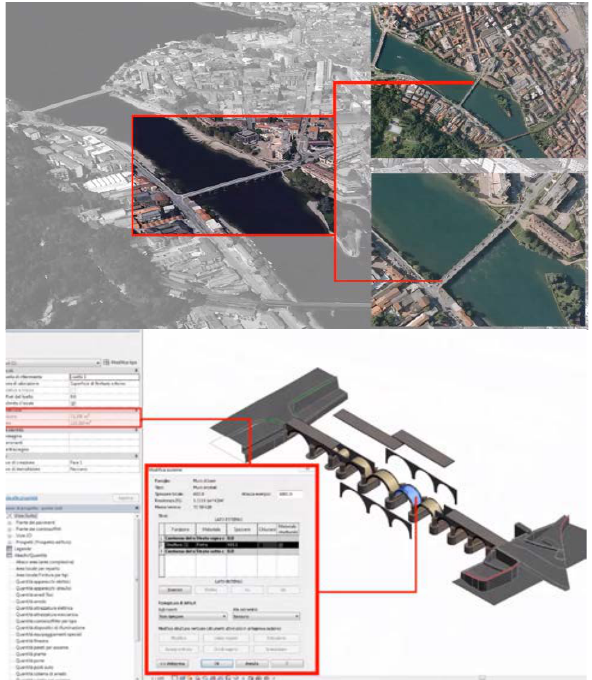
Figure 4. The integrated BIM-GIS concept for the mediaeval bridge Azzone Visconti, in Lecco